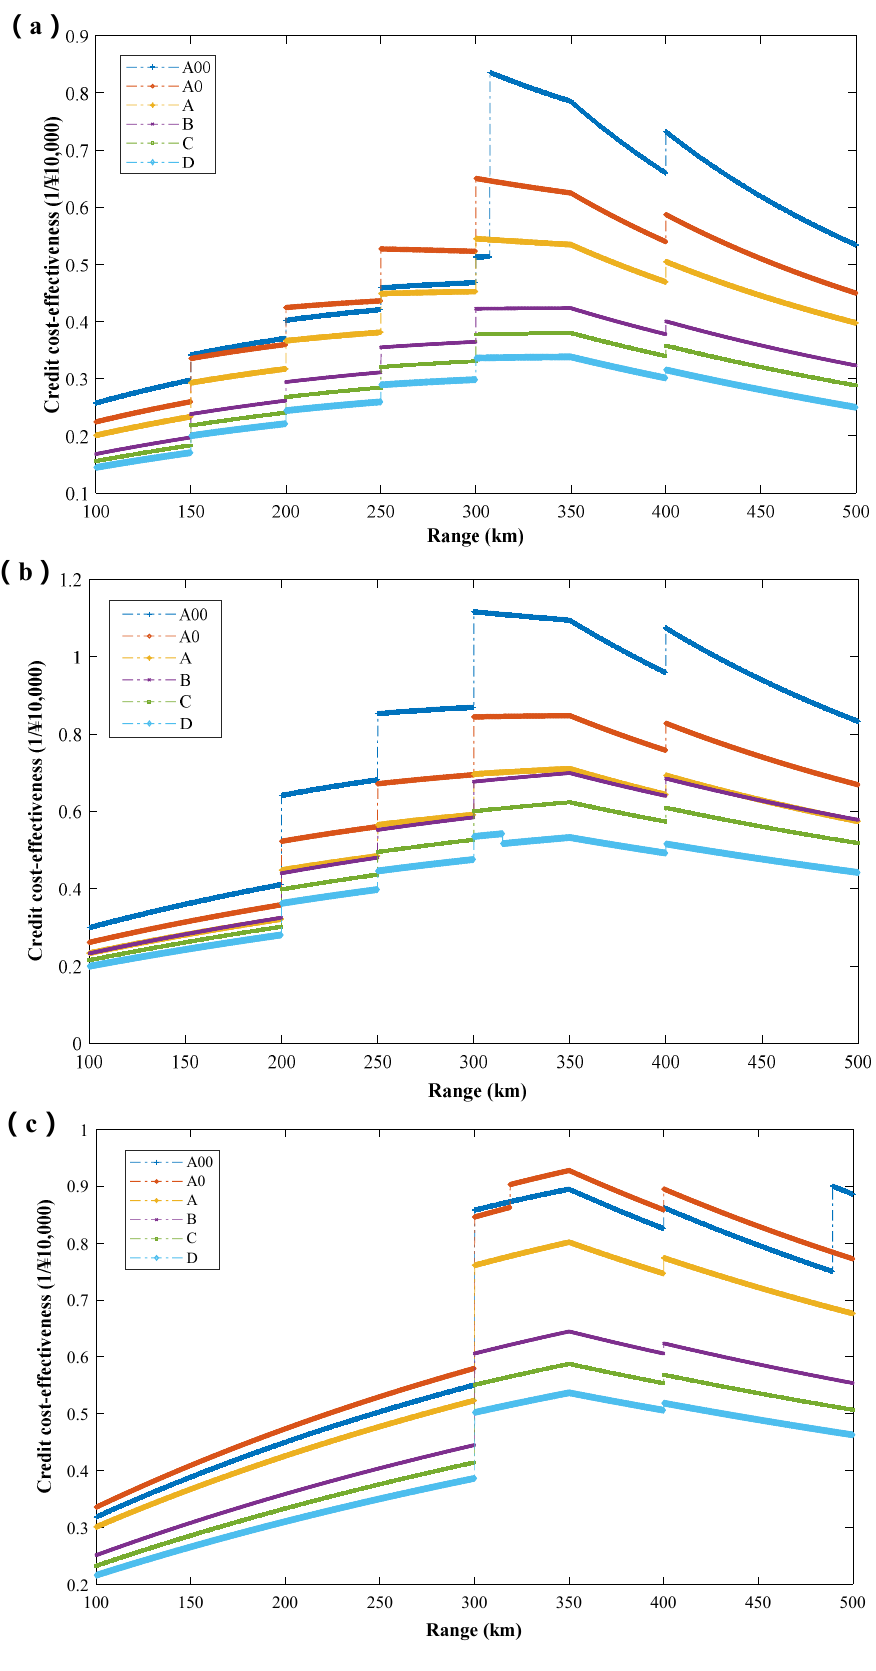
Figure 7. ( a – c ) The credit cost-effectiveness under two policies in 2018, 2020, and 2025.